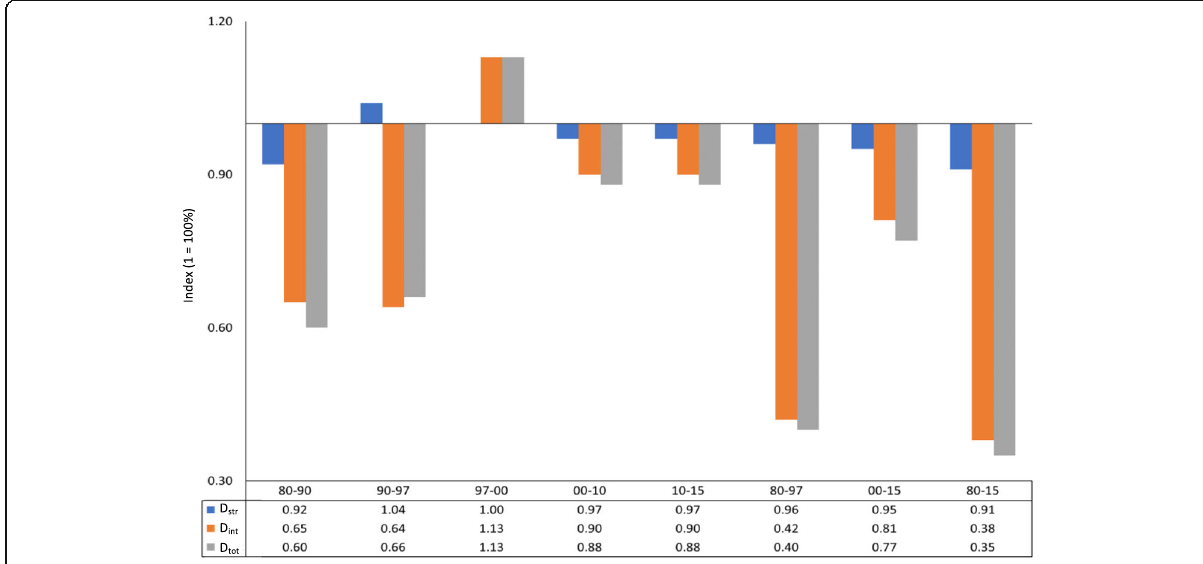
Fig. 2 Decomposition of energy intensity in manufacturing sector (9 sectors) in the period of 1980 to